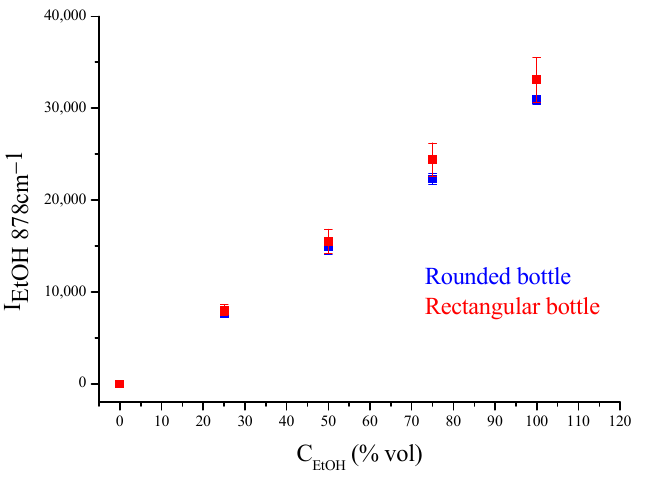
Figure 7. Intensity of the ethanol peak for ethanol–water standard solutions using a rectangular and a rounded bottle as sample holders.